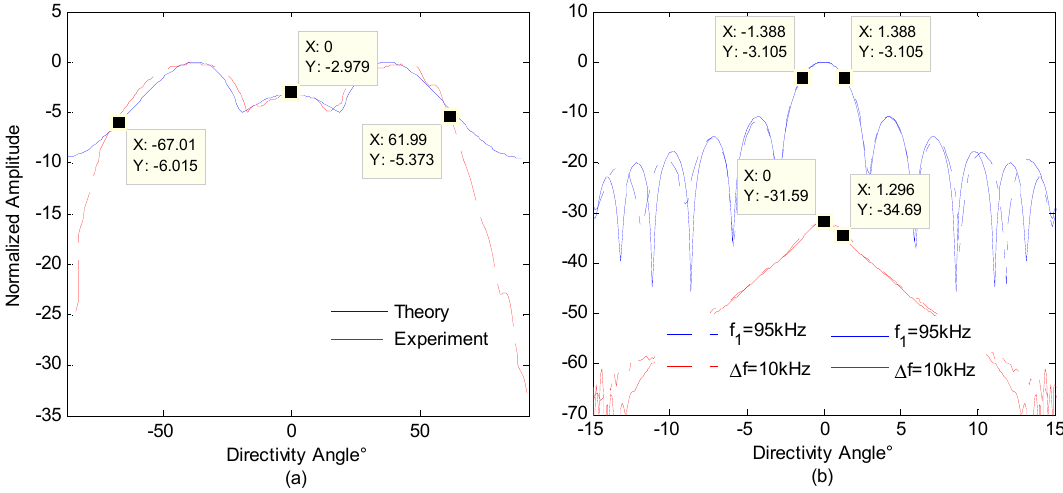
Figure 11. Directivity of the integrated detection array. ( a ) Multibeam sound source signal directivity; ( b ) sub-bottom profile sound source signal directivity.